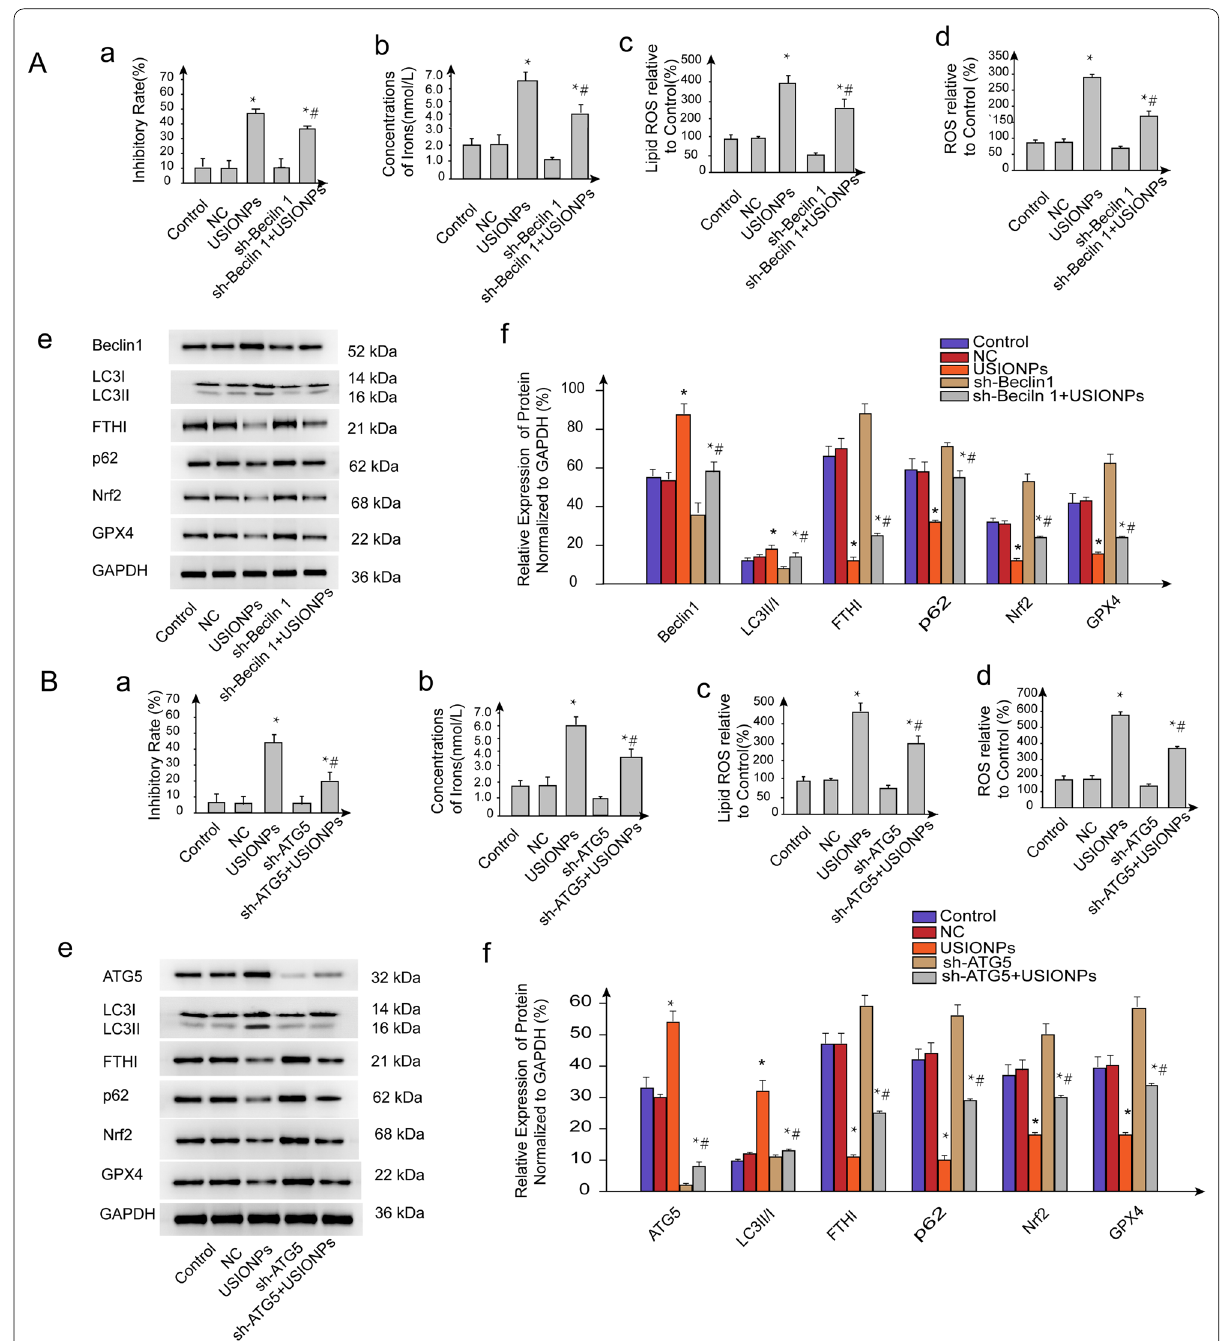
Fig. 6 Reversal effect on the USIONPs-induced ferroptosis by the interference of Beclin 1/ATG5 for 48 h. A - a Inhibitory rates of U251 cells after silencing of Beclin1 gene; A - b Concentrations of iron in the U251 cells after silencing Beclin1 gene; A - c Relative levels of lipid ROS in the U251 cells after silencing Beclin1 gene; A - d Relative levels of ROS in the U251 cells after silencing Beclin1 gene; A - e Representative images of expression of autophagy and ferroptosis related proteins in the U251 cells after silencing Beclin1 gene; A - f Relative expression of autophagy and ferroptosis related proteins in the U251 cells after silencing Beclin1 gene; B - a Inhibitory rates of U251 cells after silencing ATG5 gene; B - b Concentrations of iron in the U251 cells after silencing ATG5 gene; B - c Relative levels of lipid ROS in the U251 cells after silencing ATG5 gene; B - d Relative levels of ROS in the U251 cells after silencing ATG5 gene; B - e Representative images of expression of autophagy and ferroptosis related proteins in the U251 cells after silencing ATG5 gene; B - f Relative expression of autophagy and ferroptosis related proteins in the U251 cells after silencing ATG5 gene. * P < 0.05, statistically significant compared with control group. # P < 0.05, statistically significant compared with 200 μg/mL